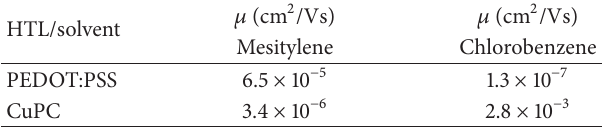
Table 4: Mean mobility 𝜇 of carriers in P3HT:PCBM blends prepared using chlorobenzene and mesitylene based solutions; 𝜇 calculated from IS measurements performed using ITO/HTL/P3HT:PCBM/Al device